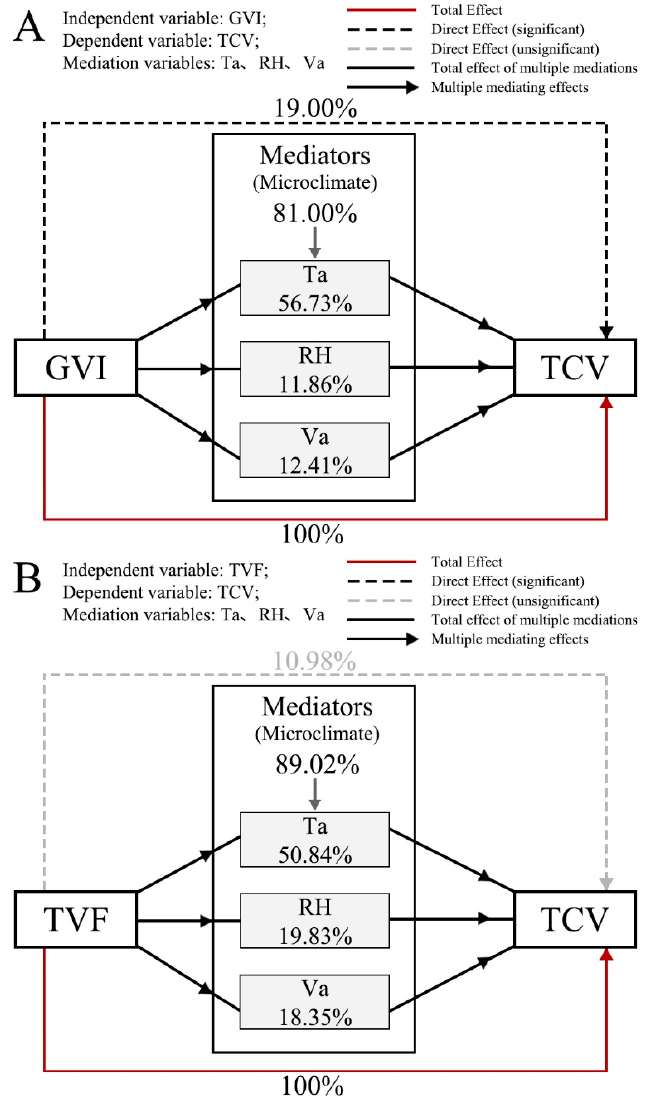
Figure 10. The impact of greenery on TCV with the microclimate as the mediator.